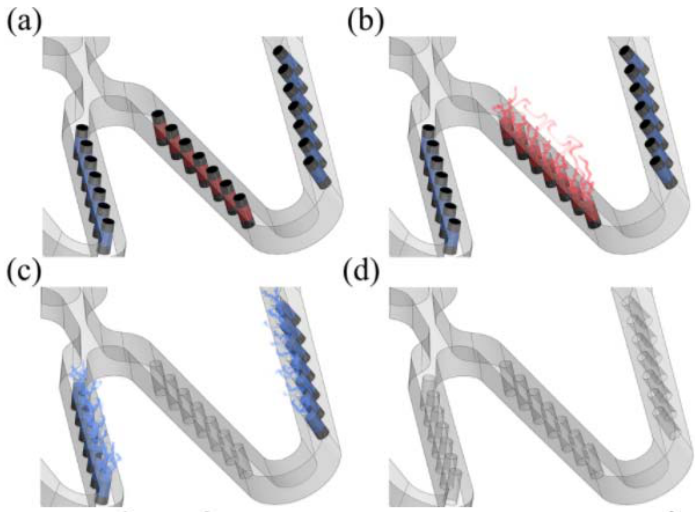
Figure 1. Schematic of sequential release of multiple drugs for each period after intervention: ( a ) depot stent with tiny reservoirs loaded with drugs A and B; ( b ) drug A eluted first; ( c ) drug B eluted next; ( d ) both drugs A and B completely eluted.